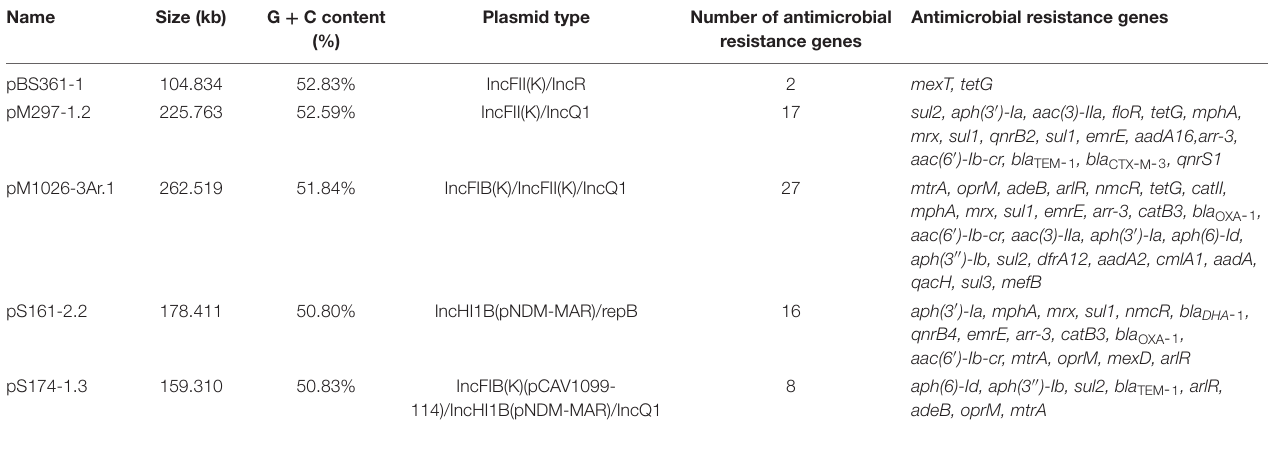
TABLE 1 | Genome information for representative multiple-replicon